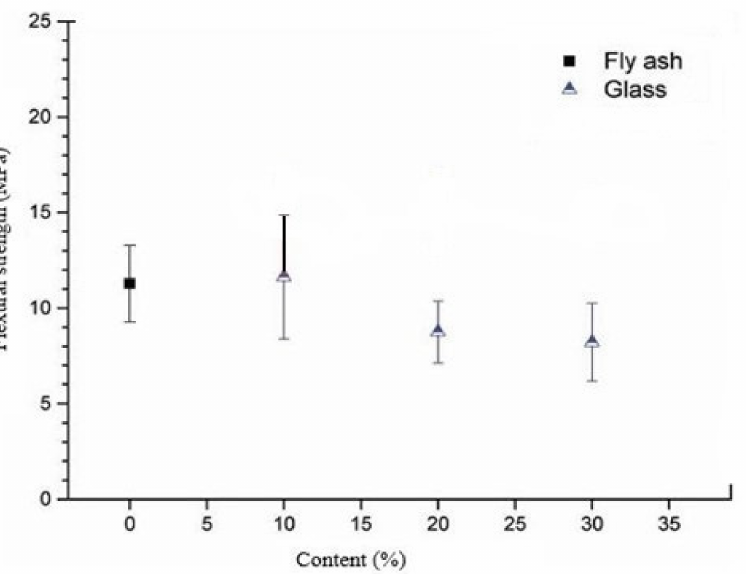
Figure 23. Flexural strength of geopolymer concrete with WG (particles size ≤ 60 µ m) compared to the fly ash precursors